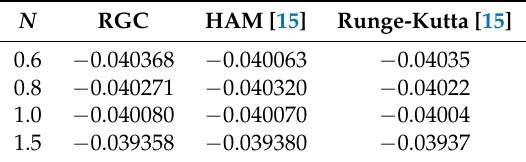
Table 3. Comparison of RGC, HAM and Runge-Kutta solution of C (cid:48) Sc = 0.24 and K = 0.2.